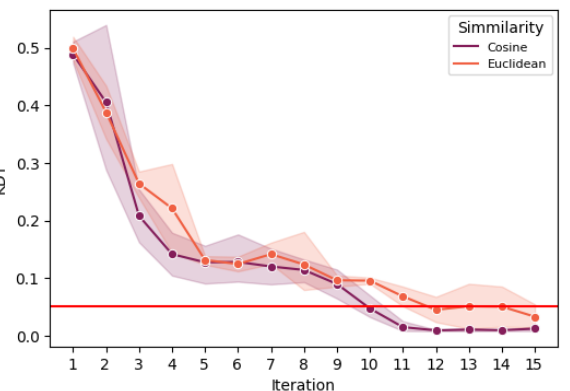
Figure 4. Learner behavior in PF3 by using either Euclidean or Cosine distance to select new solutions to query the